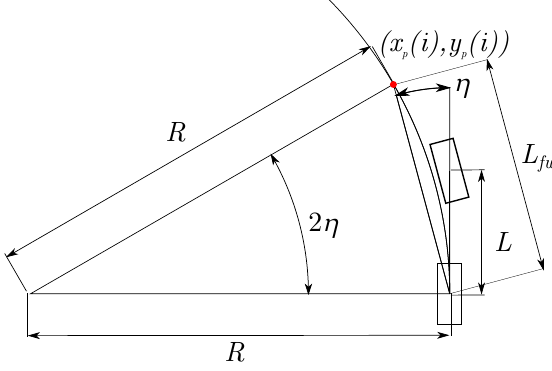
Figure 7. Pure pursuit steering